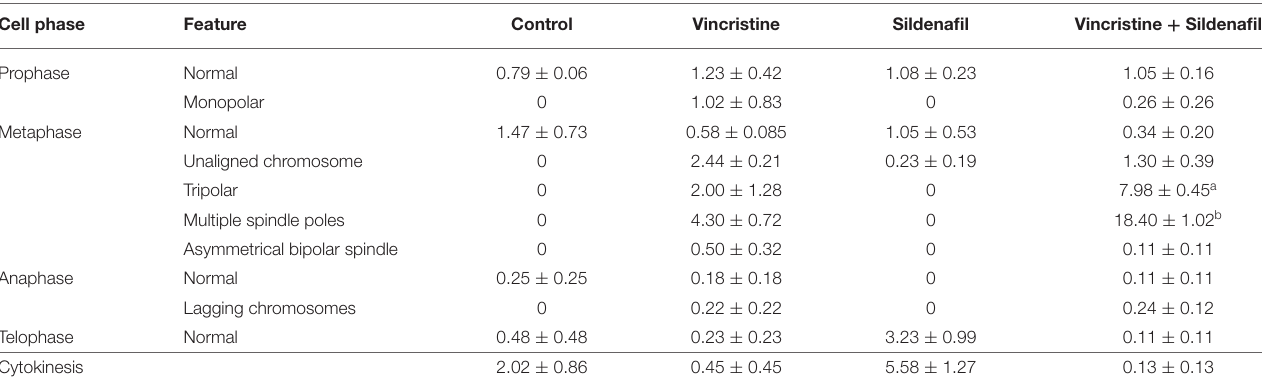
TABLE 1 | Effect of vincristine alone and combined with sildenafil on several mitotic phases in PC-3 cells. Cell